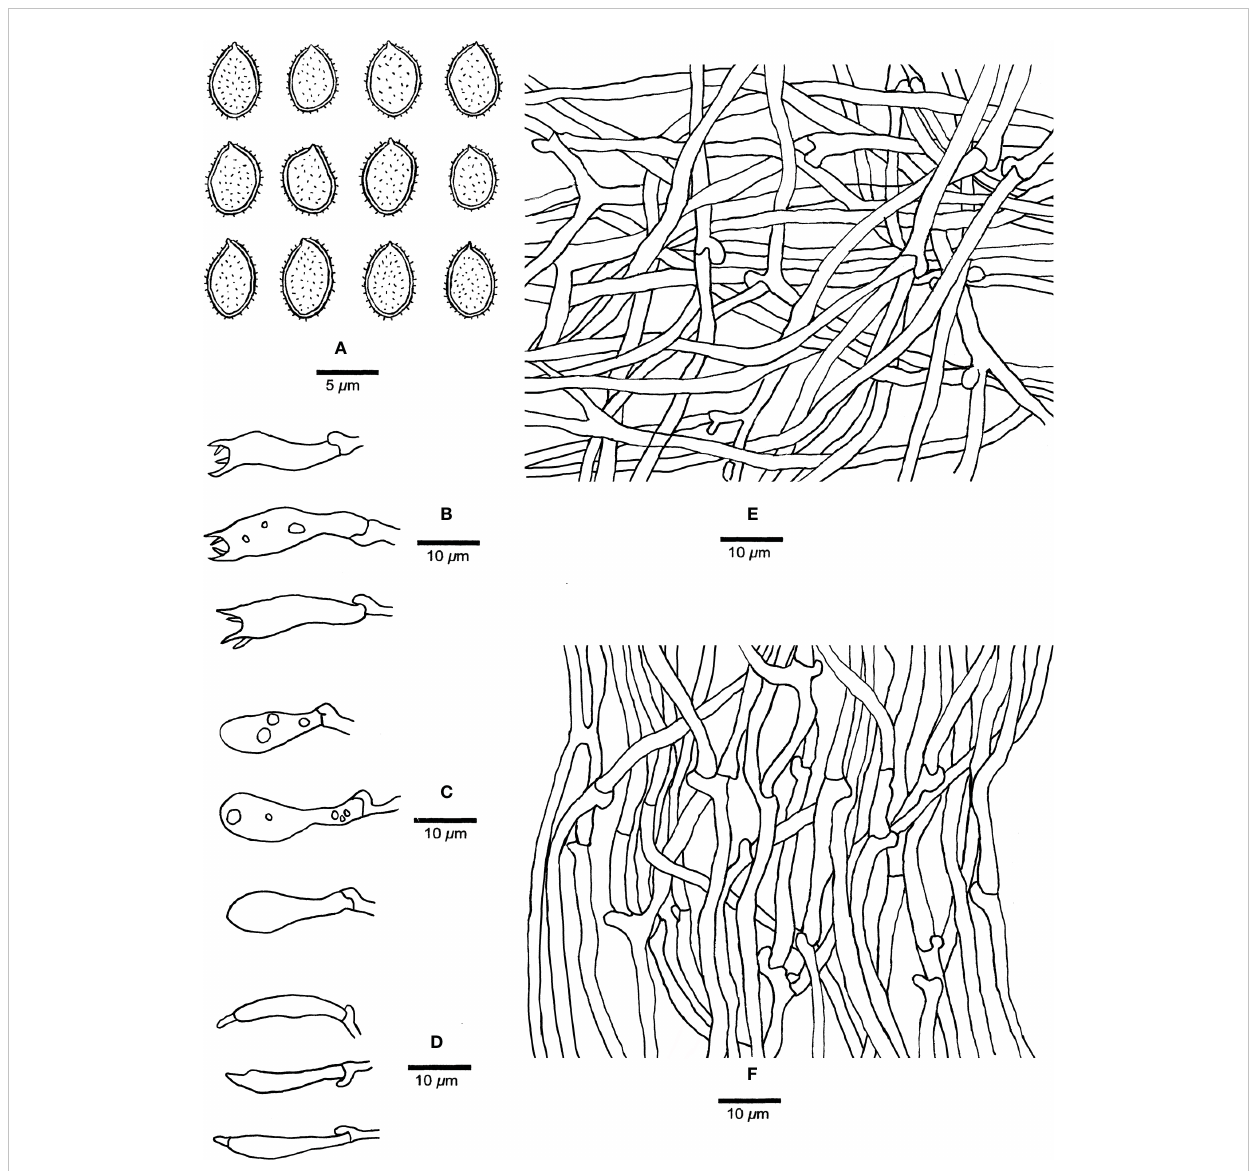
FIGURE 5 Microscopic structures of Haploporus monomitica (Holotype Dai 24446). (A) Basidiospores. (B) Basidia. (C) Basidioles. (D) Cystidioles. (E) Hyphae from subiculum. (F) Hyphae from